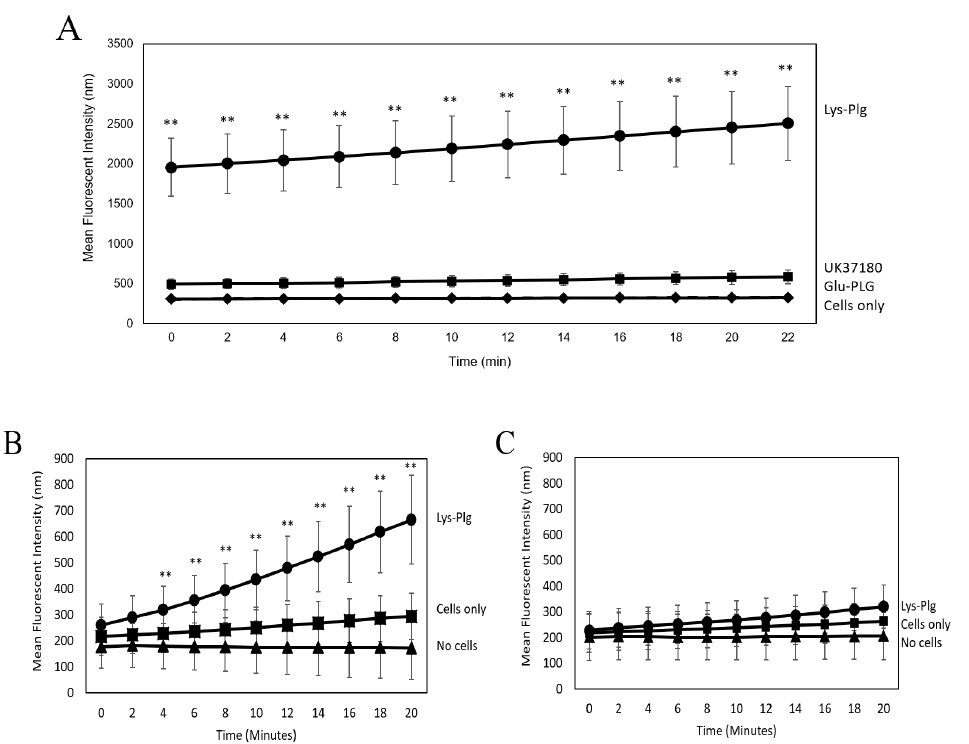
Figure 2. Plg is Activated to Pla Upon Binding to MeT5A Cells. Pla activity assays were used to assess Plg activation to Pla by MeT5A cells. ( A ) Cells were incubated for 2 h with Lys-Plg (circle), Glu-Plg (diamond), or Lys-Plg + uPA inhibitor UK371804 (square), and then the Pla substrate was added. Pla activity was measured in 2 min increments for 21 min following substrate addition. Lys-Plg showed significantly higher Pla activity compared to Glu-Plg or cell-only control (x). UK37180 significantly decreased Pla activity. To confirm Plg binding/activation at the cell surface, Pla activity was also assessed on cells ( B ) or in supernatants ( C ). Following a 1 h incubation with Lys-Plg (circle), cell-surface activity of Pla was significantly higher compared to untreated cells (square) or no cell control (triangle). In contrast, when Pla activity was measured in supernatants alone, no significant activity was noted in any treatment or control group. Each sample was run in triplicate, and experiments repeated at least twice with representative plots shown and data presented as mean ± SD, with ** p ≤ 0.001 compared to the untreated control.